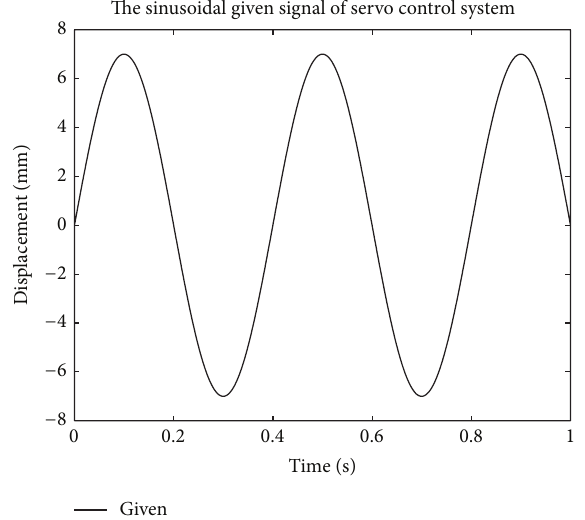
Figure 5: Nonsinusoidal reference signal of the servo control system.